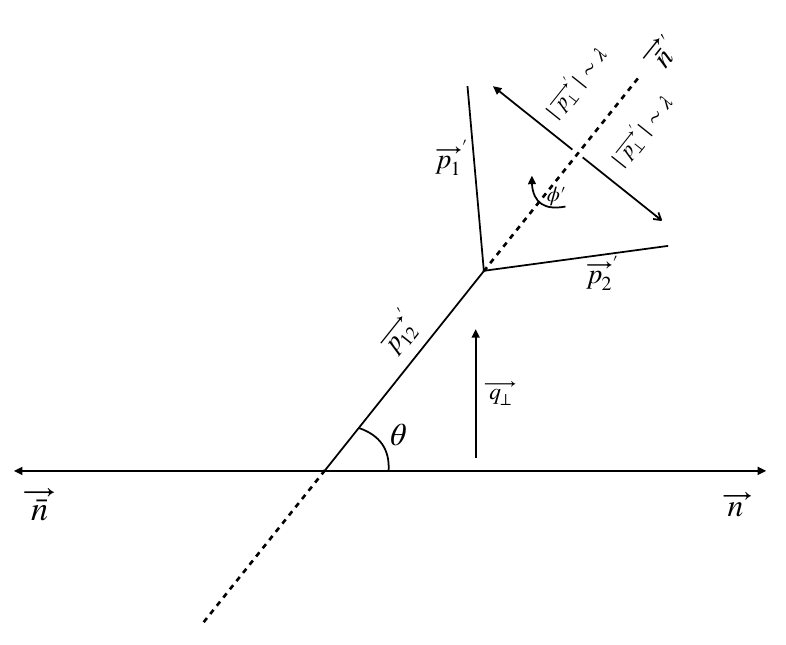
Figure 4. The setup of our calculation. The recoil is quanti(cid:12)ed by (cid:18)